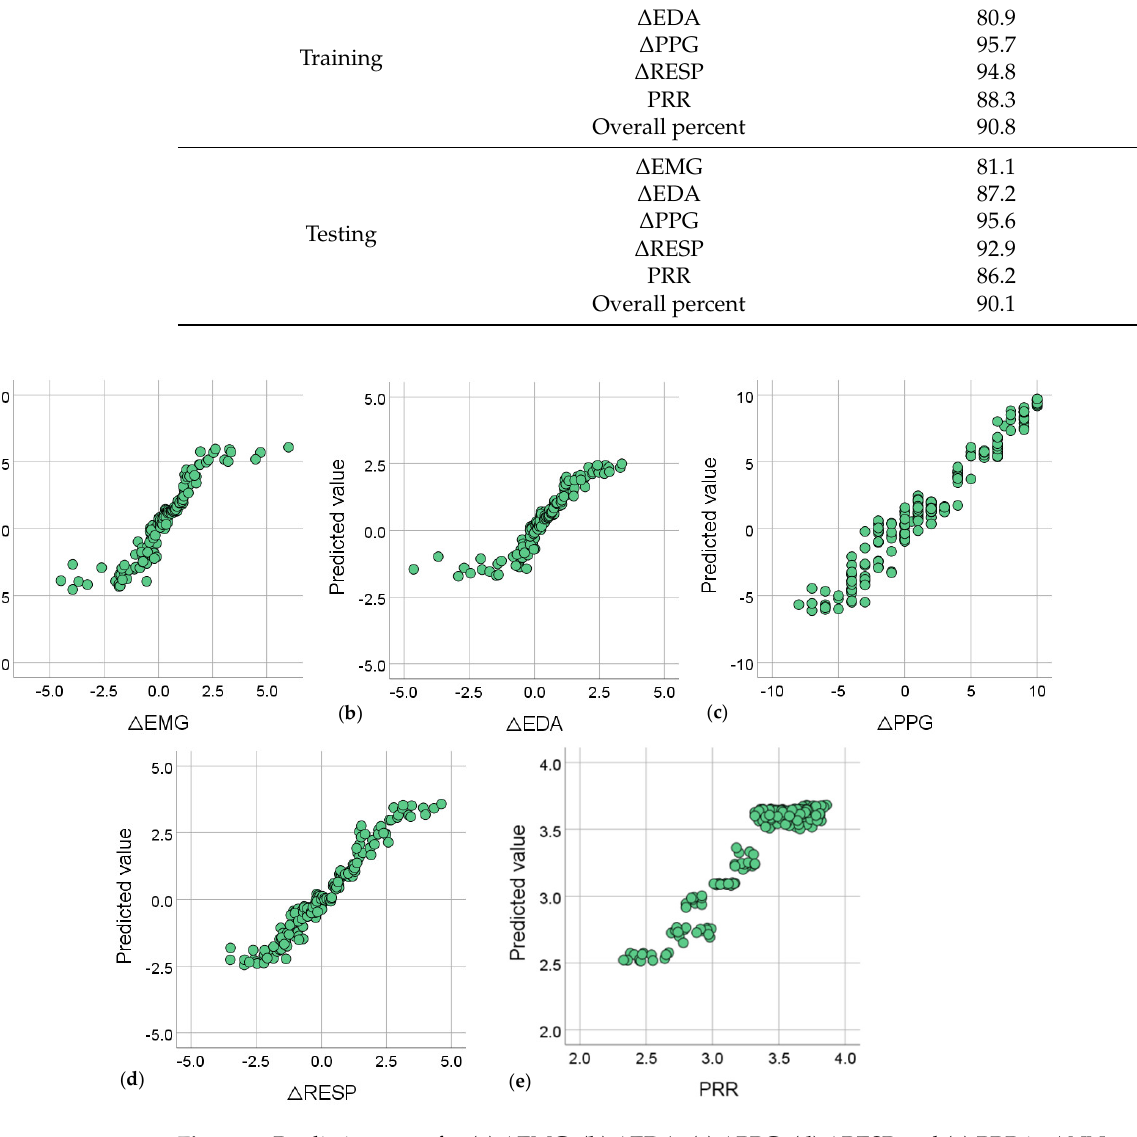
Figure 5. Prediction error for ( a ) ΔEMG, ( b ) ΔEDA, ( c ) ΔPPG, ( d ) ΔRESP and ( e ) PRR in ANNs.